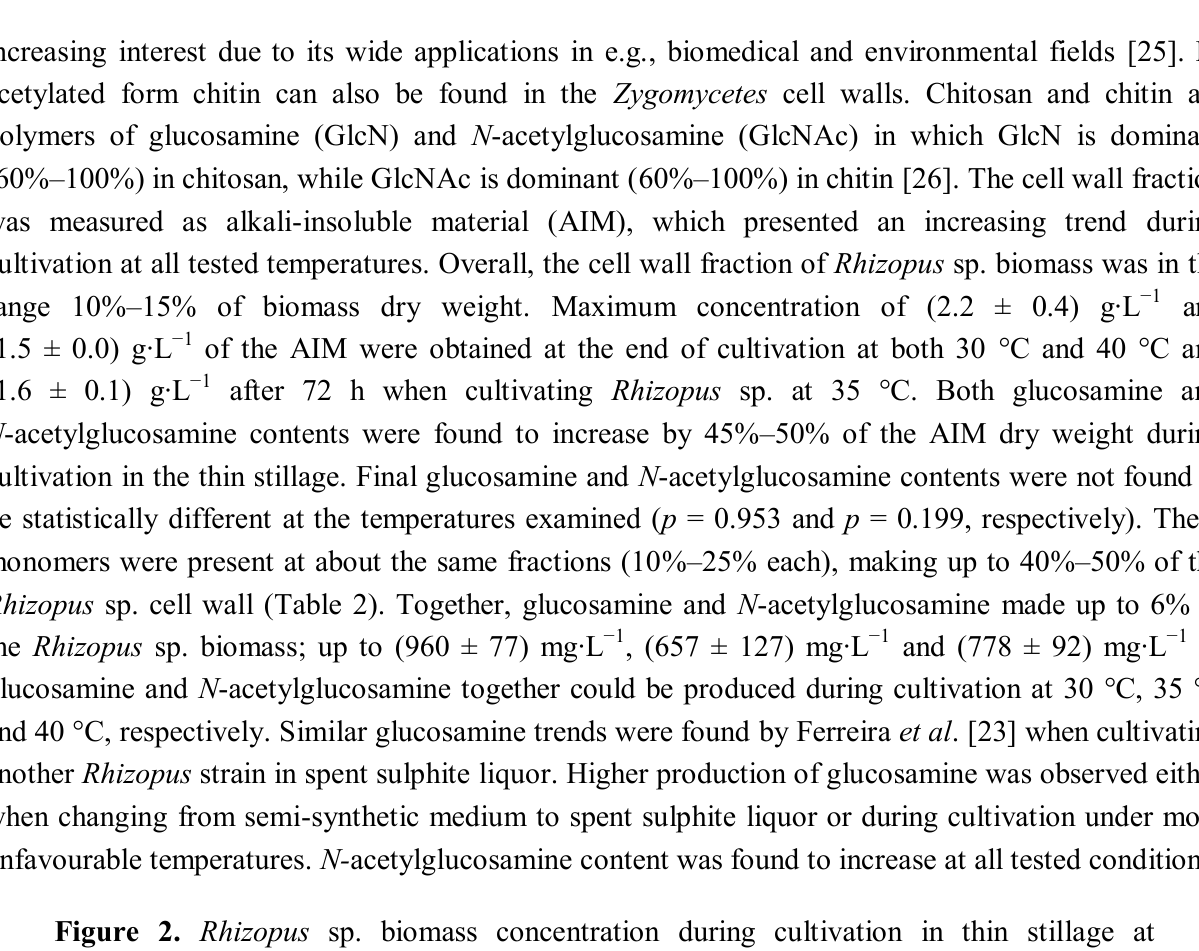
Figure 2. Rhizopus sp. biomass concentration during cultivation in thin stillage at different